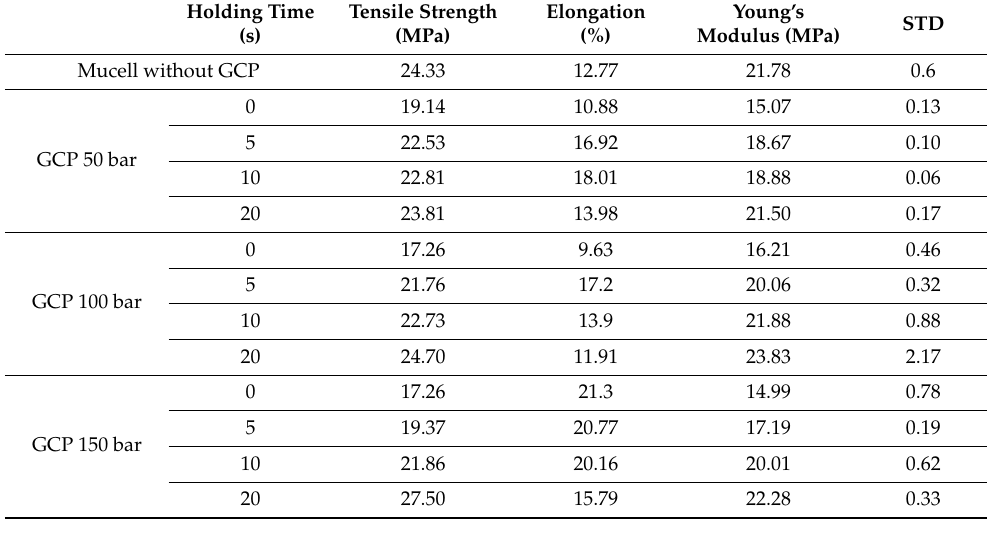
Table 5. Tensile property results of Figures 12–14.